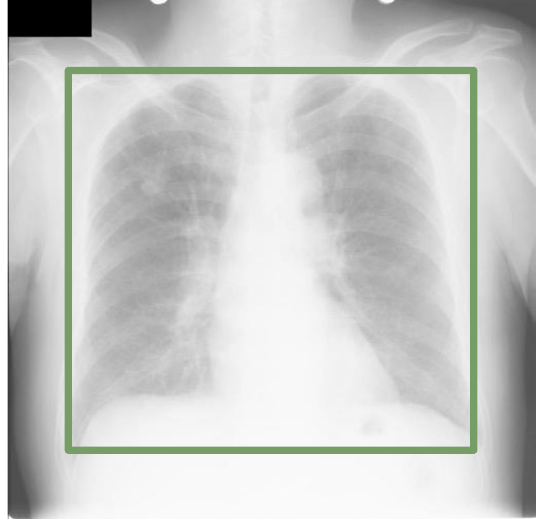
Figure 1. Lung ROI